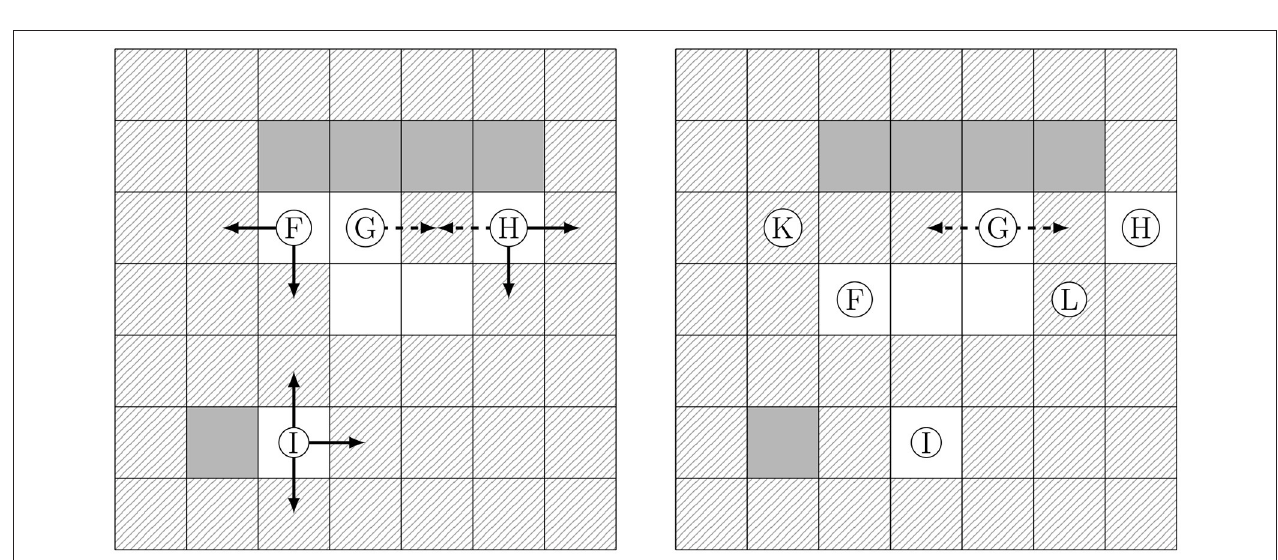
FIGURE 4 | Effects of charges in solid restructuring. Initial configuration with potential movements to target cells for a stencil of 2 (left) and consolidated configuration following the strongest attraction for each particle (right) . Straight and broken lines indicate opposite charges at the faces of the solid particles.